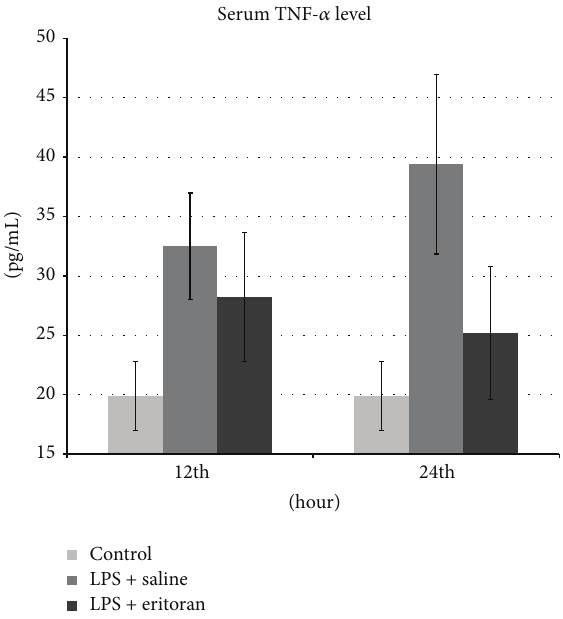
Figure 1: The tumor necrosis factor- 𝛼 (TNF- 𝛼 ) levels in serum after 12h and 24 h in control group with no intervention, rats with sepsisbutwithouteritoran,andratswithsepsistreatedwitheritoran. Vertical lines show standard deviation. LPS: